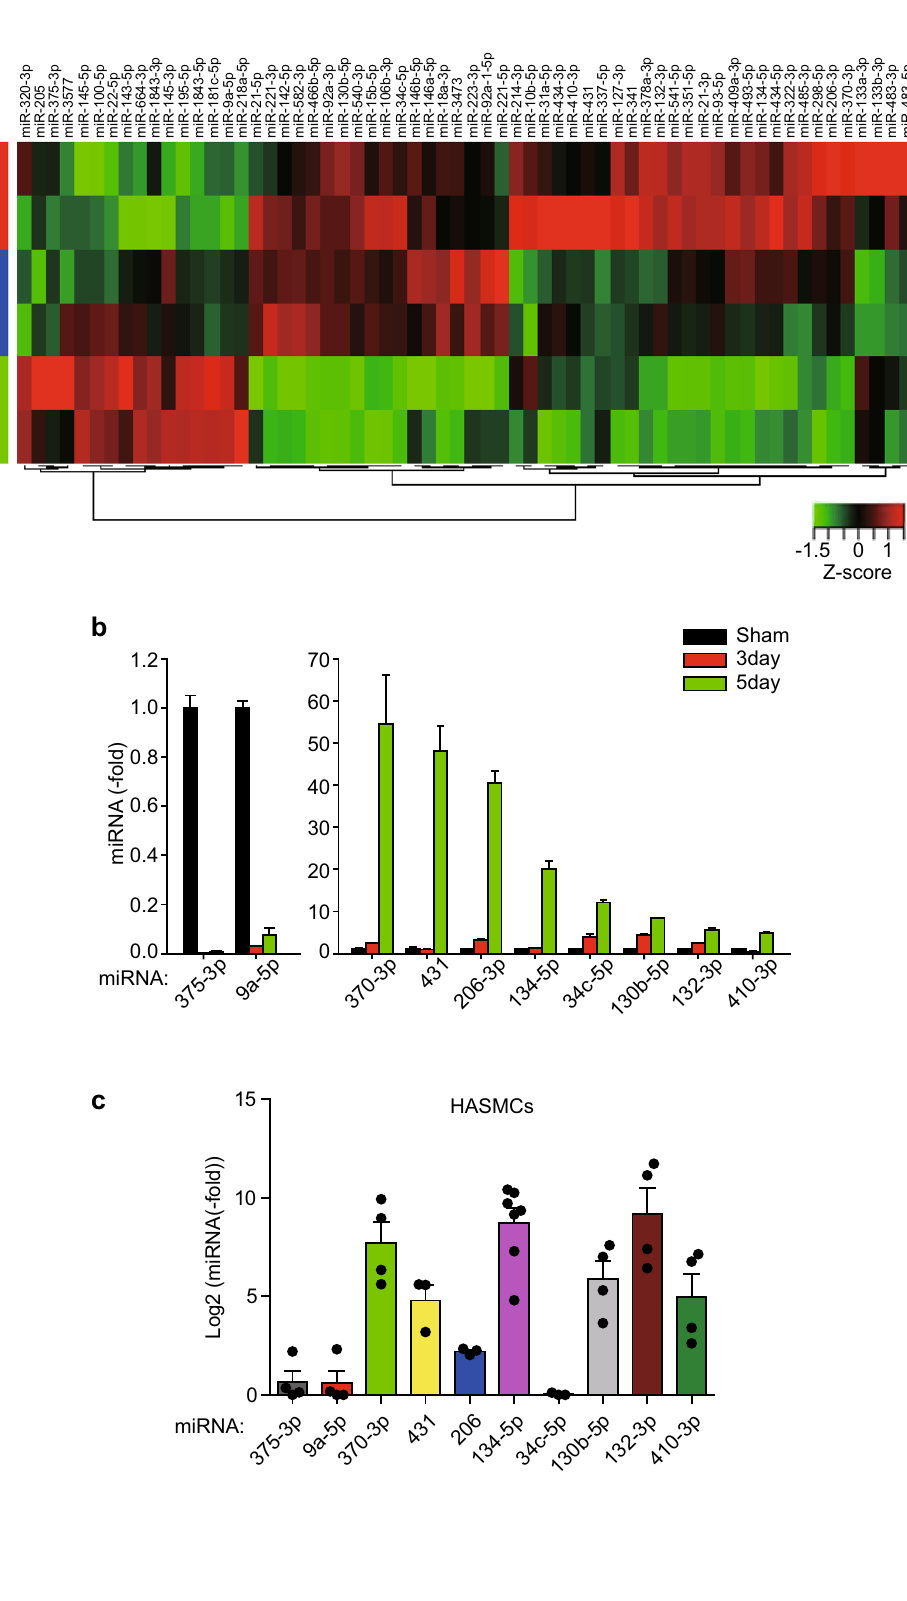
Figure 1. Profiling of miRNA expression at the early stage of the neointimal hyperplasia. ( a ) Heatmap depicting the relative expressions and correlations of the arterial 62 miRNAs identified by the small RNA sequencing in the balloon- injured rat carotid arteries ( n = 2). ( b ) Relative expression levels of the rat arterial miRNAs. The carotid arteries were harvested at the indicated time points after balloon injury and pooled for miRNA-specific qPCR. Data in the graph are means ± SD of fold changes compared to sham control ( n = 2). ( c ) Relative expression levels of the selected miRNAs in the cultured HASMCs. Data in graph are means ± SEM of the fold changes relative to the miR-375-3p level ( n =